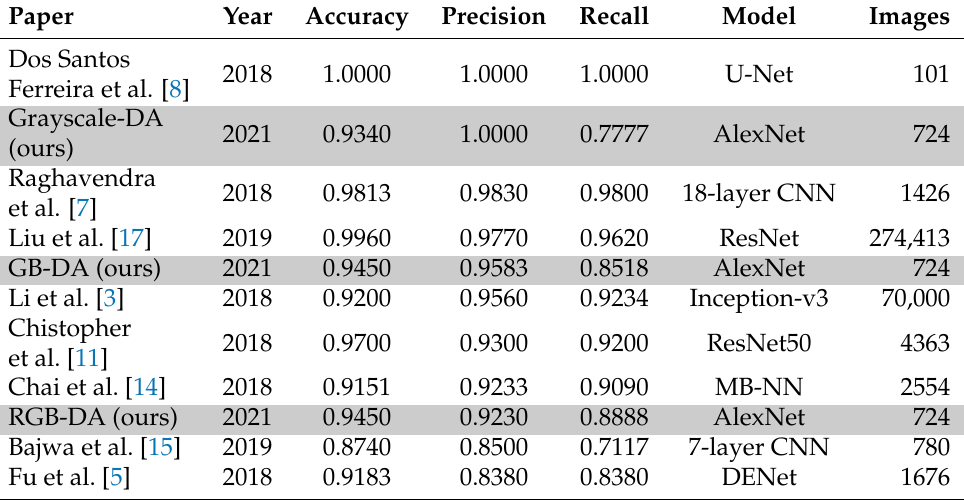
Table 3. Comparison between our best results vs. the state of the art (sorted by precision).